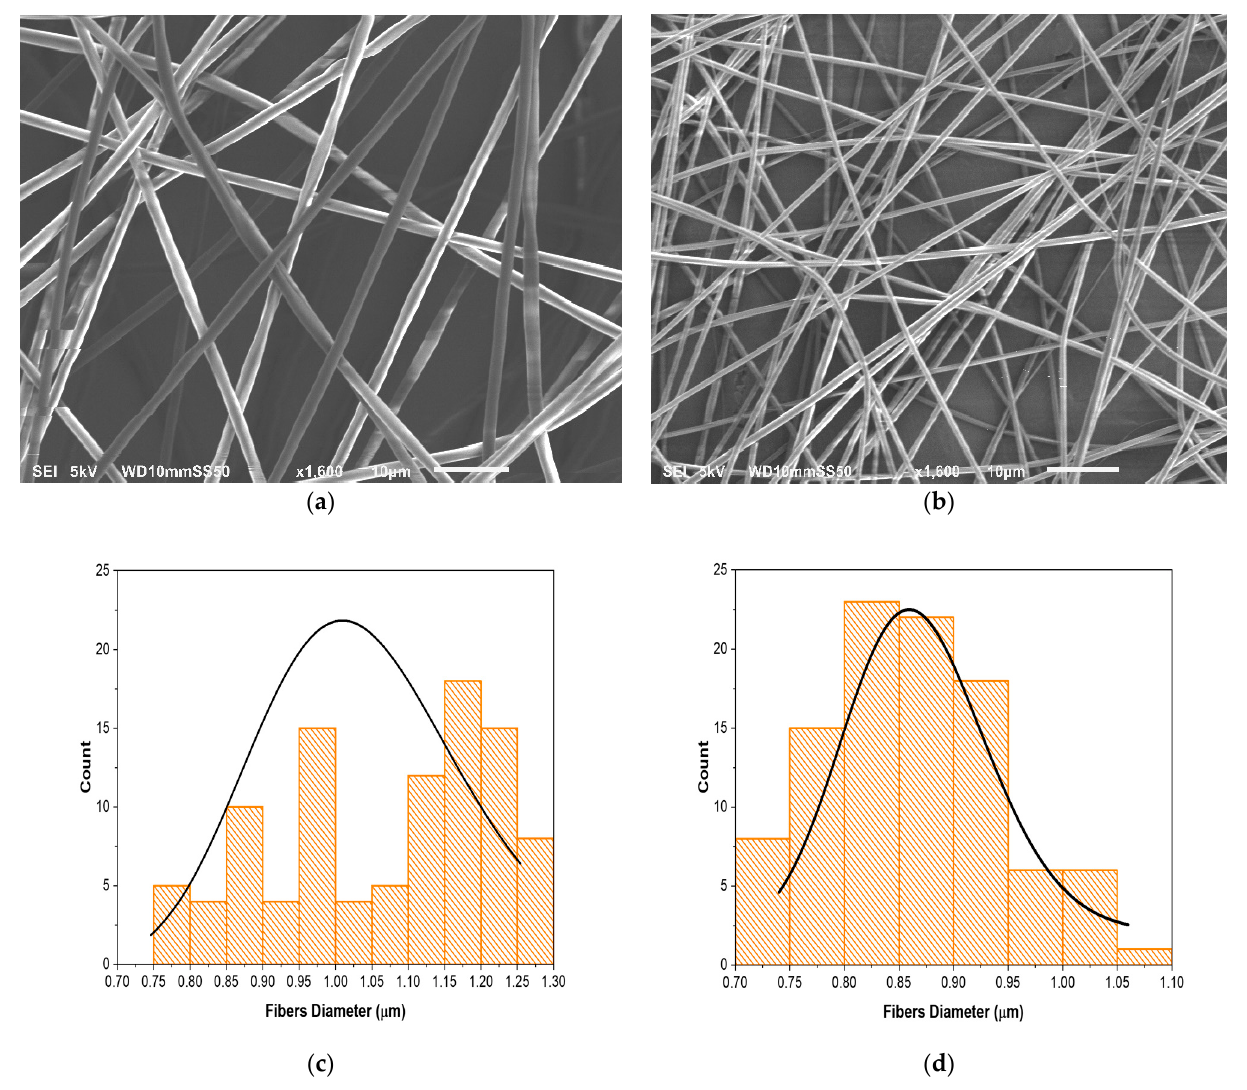
Figure 1. SEM images of ( a ) blank fibers, ( b ) drug-loaded fibers, ( c ) blank fibers size distribution, ( d ) drug-loaded fibers size distribution. The blank and drug-loaded fibers were smooth, un-beaded, and non-porous with a fiber diameter of 1 ± 0.2 and 0.9 ± 0.1 µm, respectively.